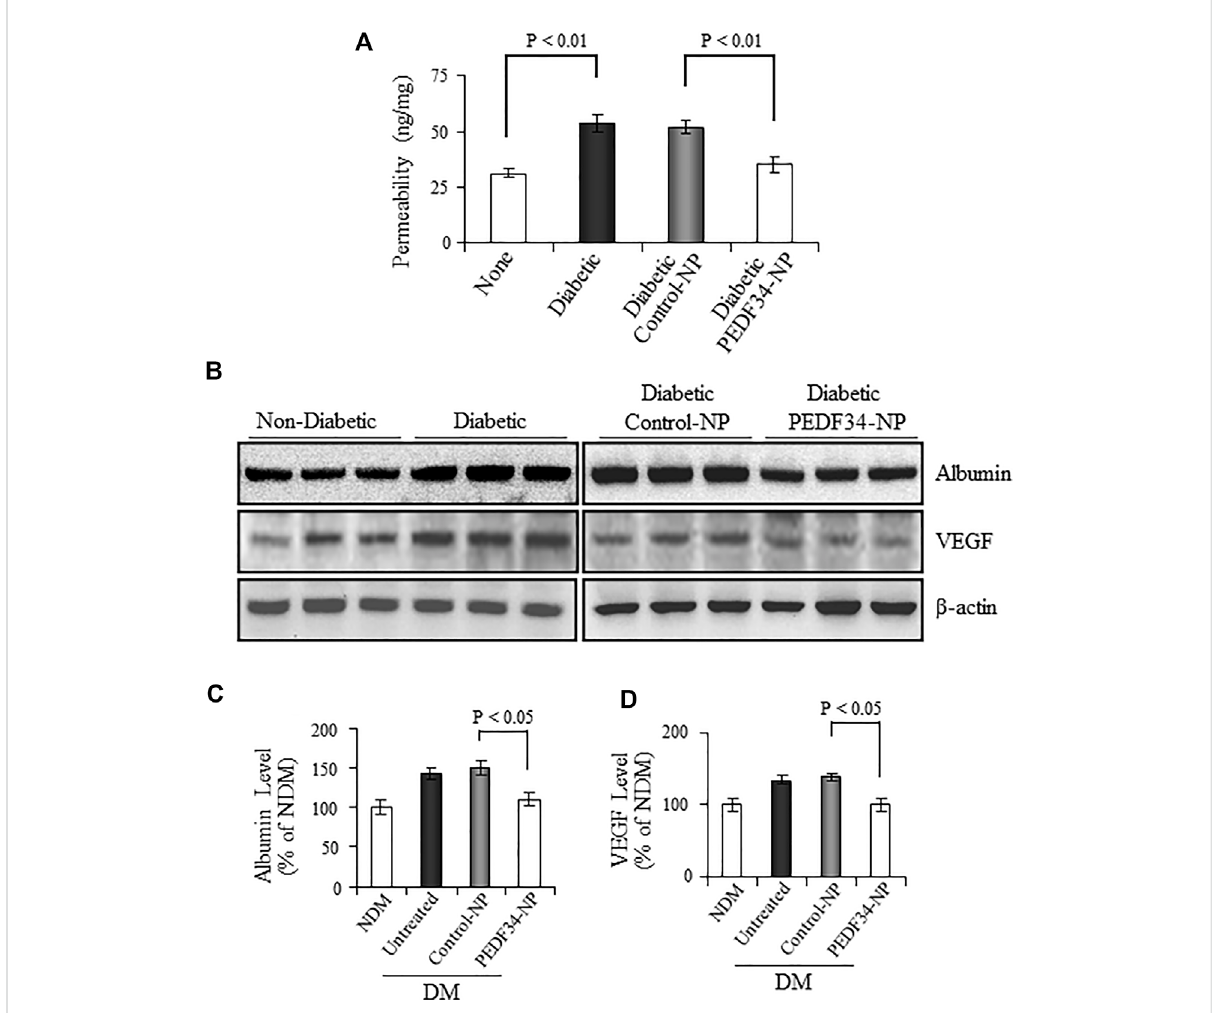
FIGURE 4 Effect ofPEDF34-NPonretinal vascularleakageinSTZ-induceddiabeticrats. Diabeticrats receivedanintravitrealinjectionof5 μ g PEDF34-NP or Control-NP. (A) Four weeks after the injection, retinal vascular permeability was measured using Evans blue as tracer and normalized by total retinal protein concentration (mean ± SD, n= 5). (B – D) Retinas were dissected after perfusion, and the levels of albumin and VEGF were determined by western blot analysis, normalized to β -actin levels, semi-quanti fi ed by densitometry, and expressed as % of those in non-diabetic rat retinas (mean ± SD, n =